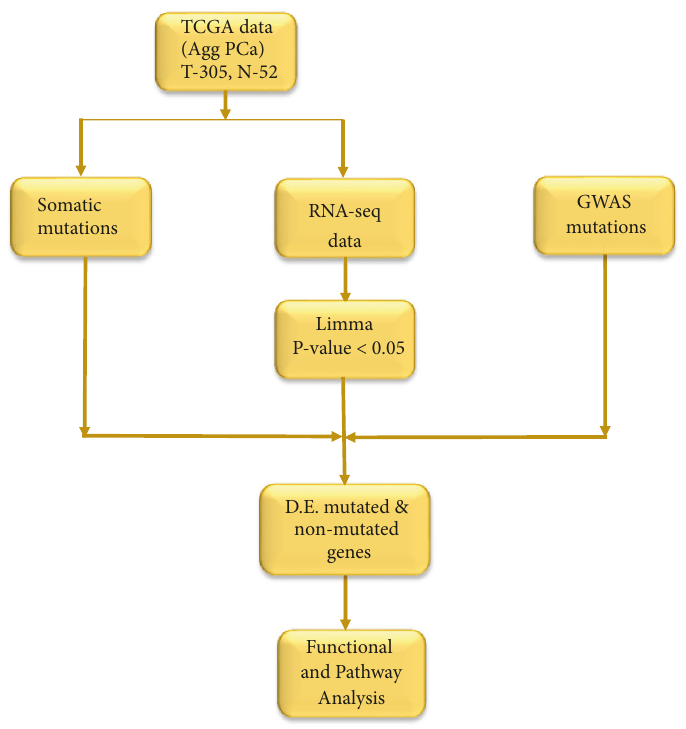
Figure 1: Design and workflow for integrative analysis combining germline with somatic mutation information using gene expression data. RNA-seq read count data and somatic information were downloaded from The Cancer Genome Atlas (TCGA) via the Genomics Data Commons. Germline mutation information was manually curated from GWAS studies. Limma (R) package was used for the discovery of differentiallyexpressed(DE)mutatedandnonmutatedgenes.IngenuityPathwayAnalysis(IPA)wasusedforfunctionalanalysisanddiscovery of molecular networks and biological pathways enriched for germline and somatic